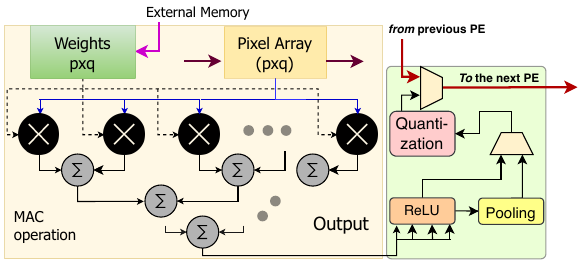
Figure 8. Block diagram of the Processing Unit (PE). It performs MAC operations, rectification, pooling (when required), and